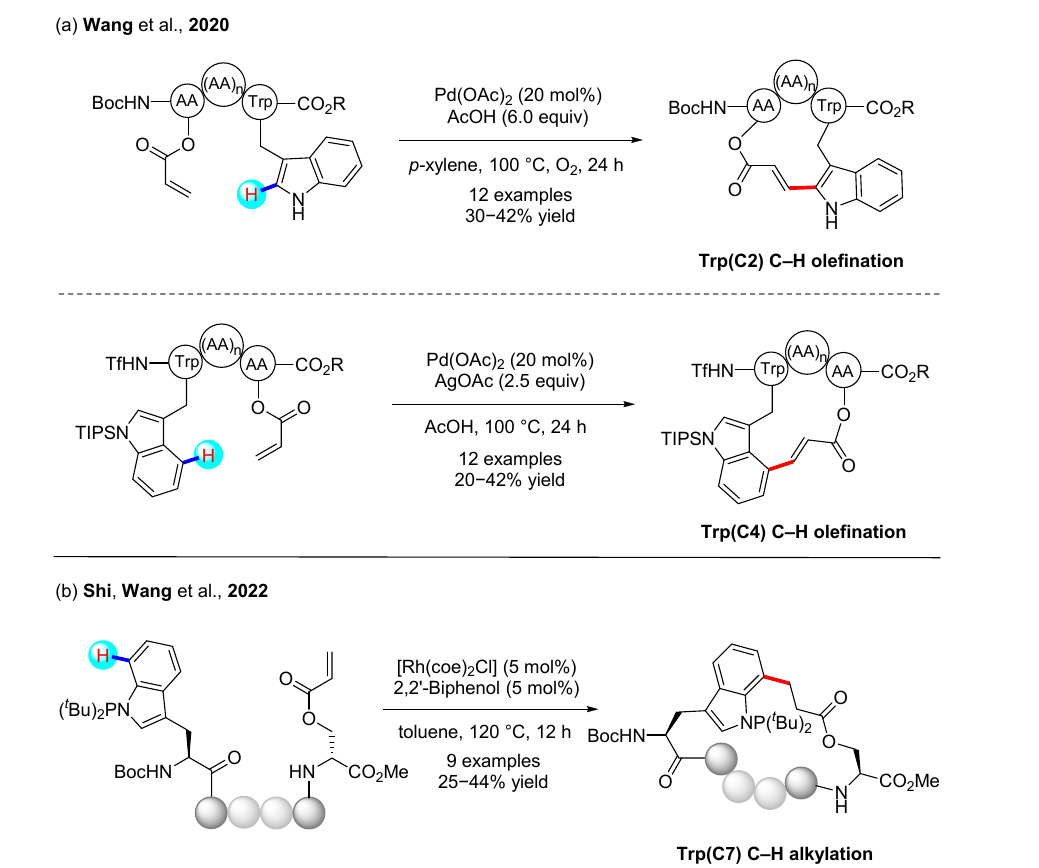
Figure 10. Peptide macrocyclizations via site ‐ selective intramolecular C(sp 2 ) − H bond functionalization of tryptophan [68,69].